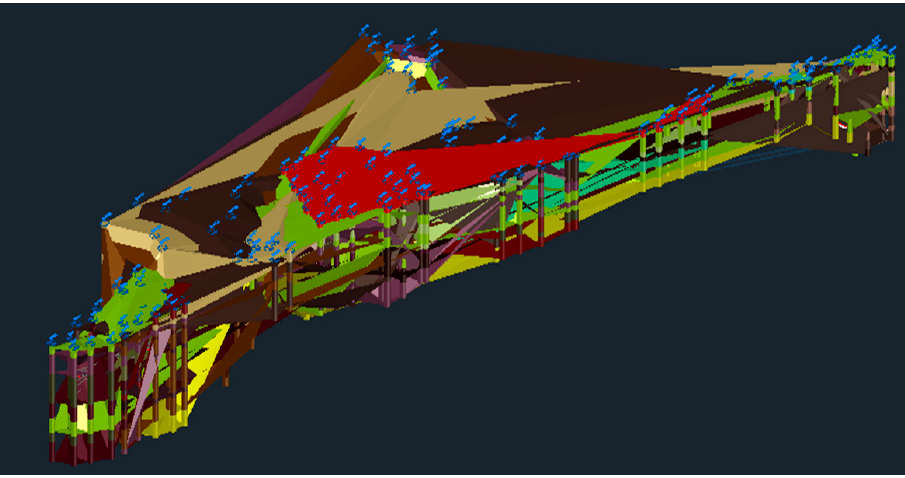
Figure 4. 3D subsurface model for Case Study 1 based on detailed soil investigation data.